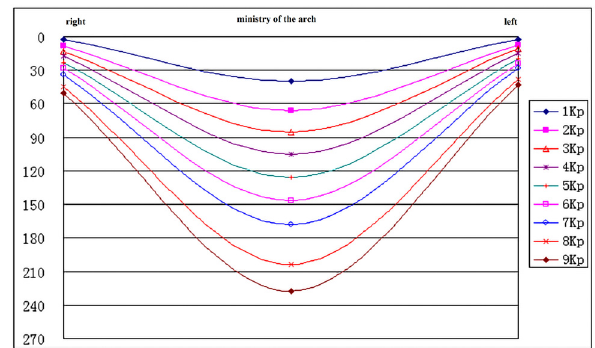
Figure 18: Radial displacement distribution of downstream surface at dam elevation of 2,059